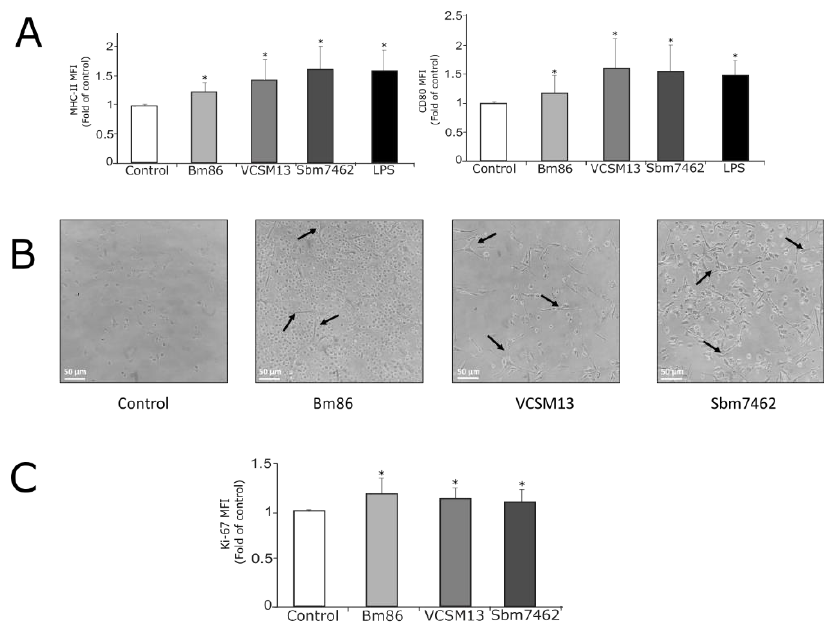
Figure 5. Phage-based vaccine induces maturation of bovine monocyte-derived dendritic cells. ( A ) Representative graphs showing the fold increase of mean fluorescence intensity (MFI) of MHC class II and CD80+ of bovine MODCs untreated (negative control), pulsed with 0.24 µg Bm86 antigen (positive control), 4 × 10 10 PFU of VCSM13 helper phage (nude phage), 4 × 10 10 PFU of Sbm7462 expressing-phage (equivalent to 0.24 µg of recombinant Sbm7462 peptide) or stimulated with 1 µg/mL of LPS (positive control) during 18.5 h. Each well contained 300,000 cells. ( B ) Morphology of monocyte-derived dendritic cells pulsed with or without antigens. ( C ) Proliferation of PBMC restimulated with or without antigens measured through the expression of protein ki-67. Graphs shown represent the means (±SD) of six independent experiments. n = 6. * p -value < 0.05 compared to control group.